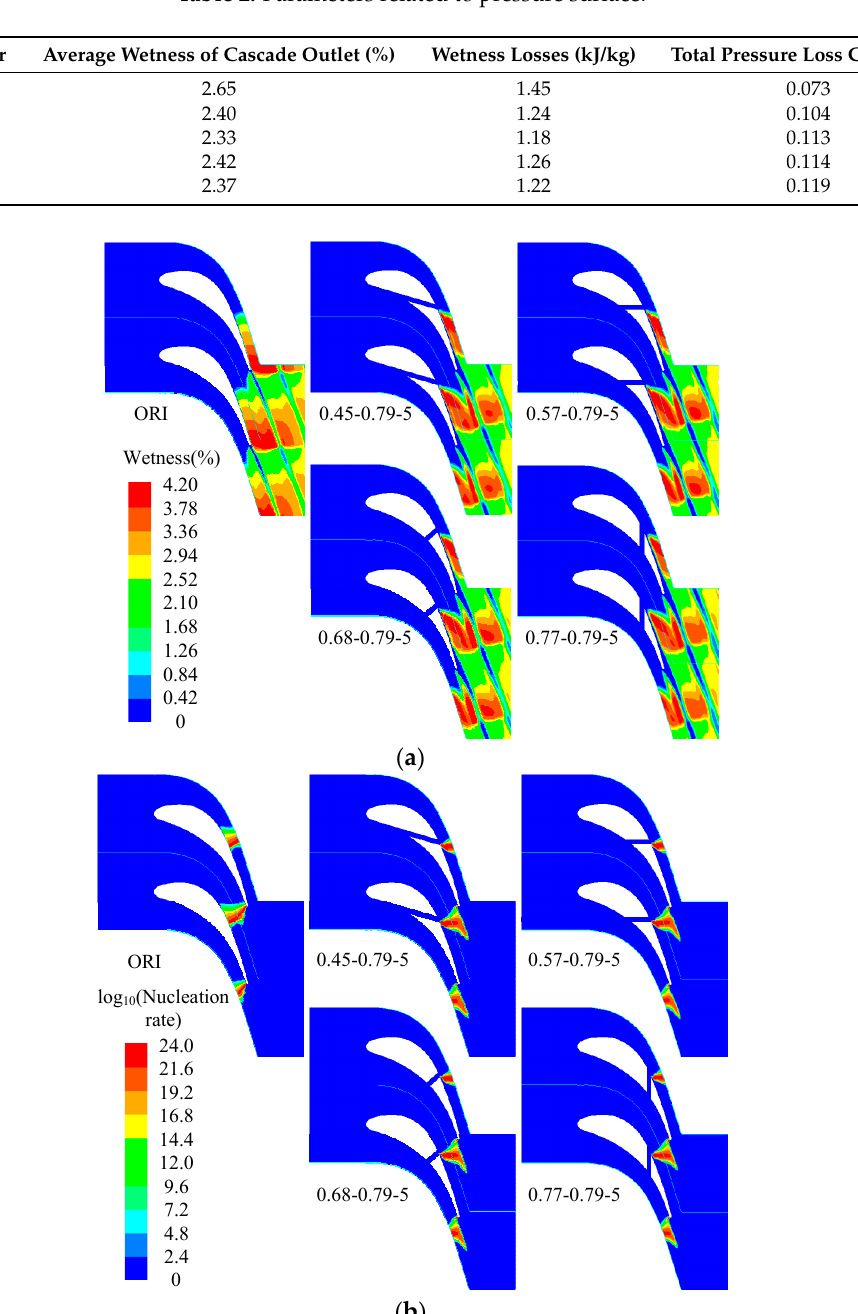
Table 2. Parameters related to pressure surface.